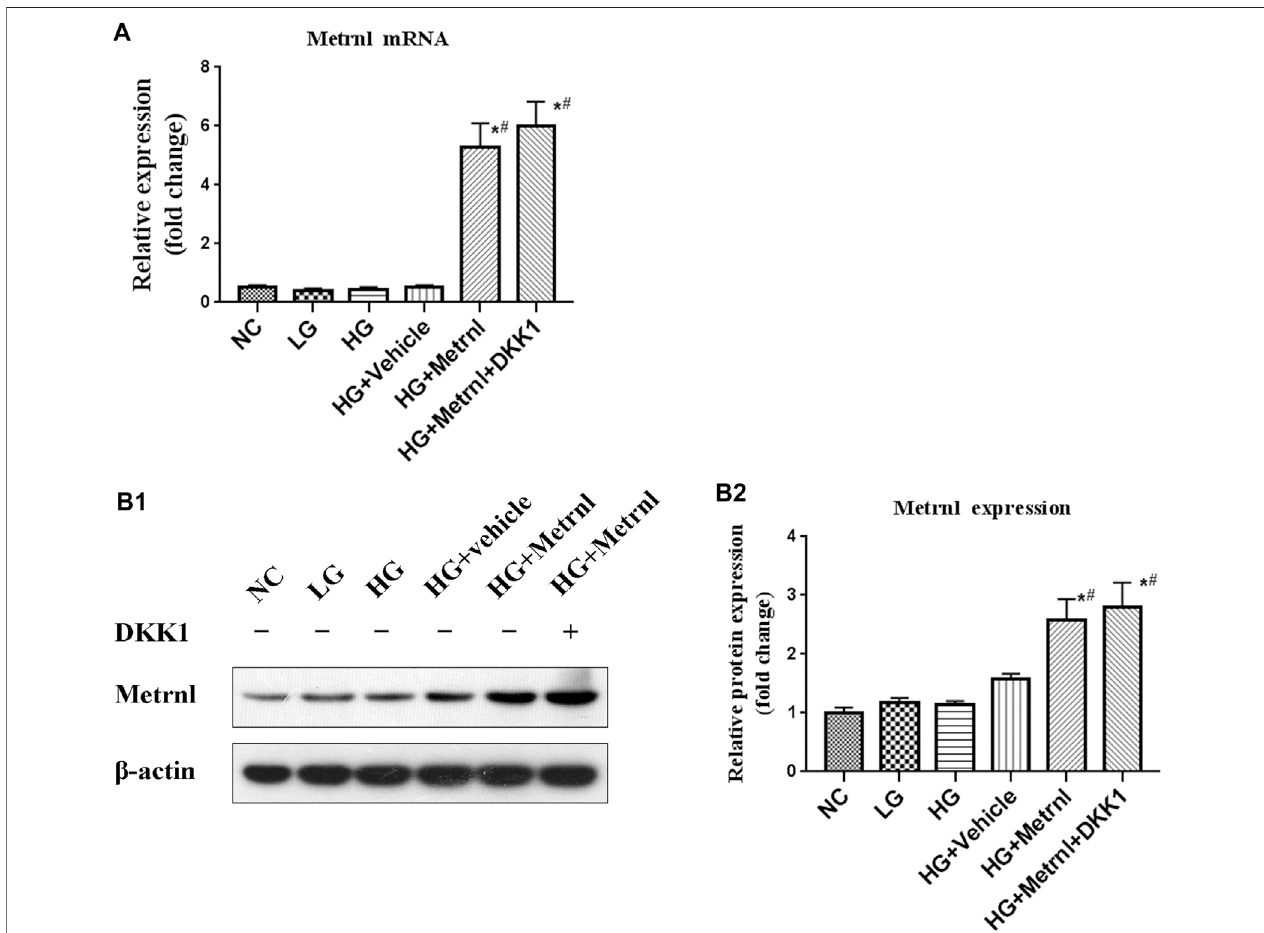
FIGURE2 | The expression of Metrnl after pCDH-Metrnl vector transfection. (A) Thegene expression ofMetrnl quanti fi ed by real-time PCR. Dataare presented as thefoldchangeoftranscriptsforthetargetgeneintheindicatedgroupsnormalizedto β -actin. (B) RepresentativewesternblotshowingMetrnlproteinlevelsinMIN6cells of different groups. Band densities were converted to a bar graph. All data are expressed as mean ± SEM ( n (cid:2) 8/group [mRNA], n (cid:2) 8/group [protein]). * p < 0.05 for differences vs. normal control group; # p < 0.05 for differences vs. HG group. NC: normal control, LG: low glucose, HG: high glucose, DKK1: dickkopf